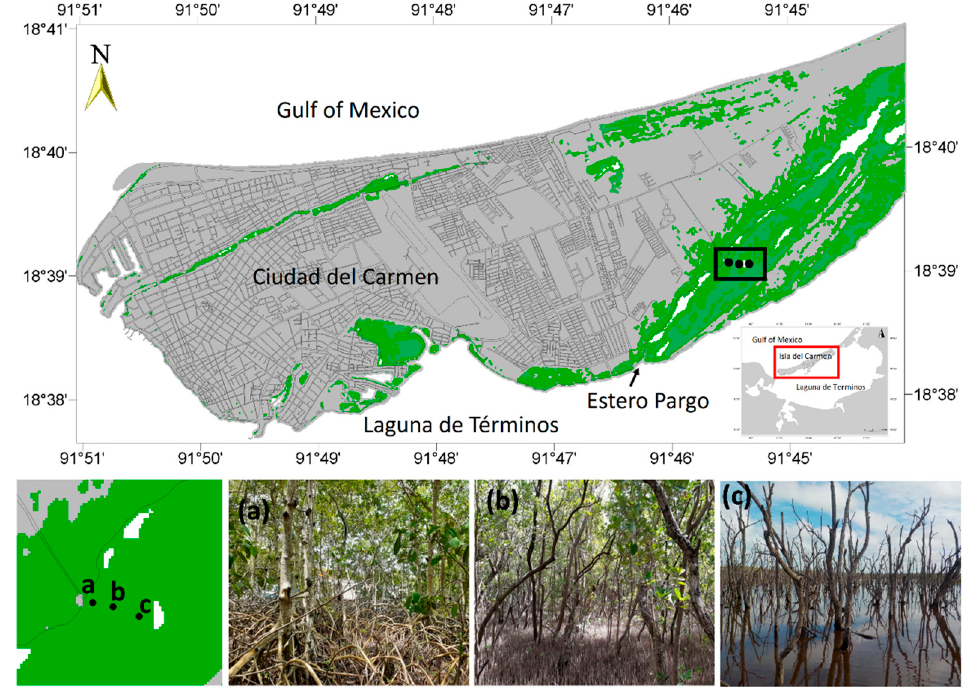
Figure 1. Location of Estero Pargo mangrove in Ciudad del Carmen, Campeche, Mexico. ( a ) Fringe mangrove, ( b ) basin mangrove, and ( c ) impaired site.